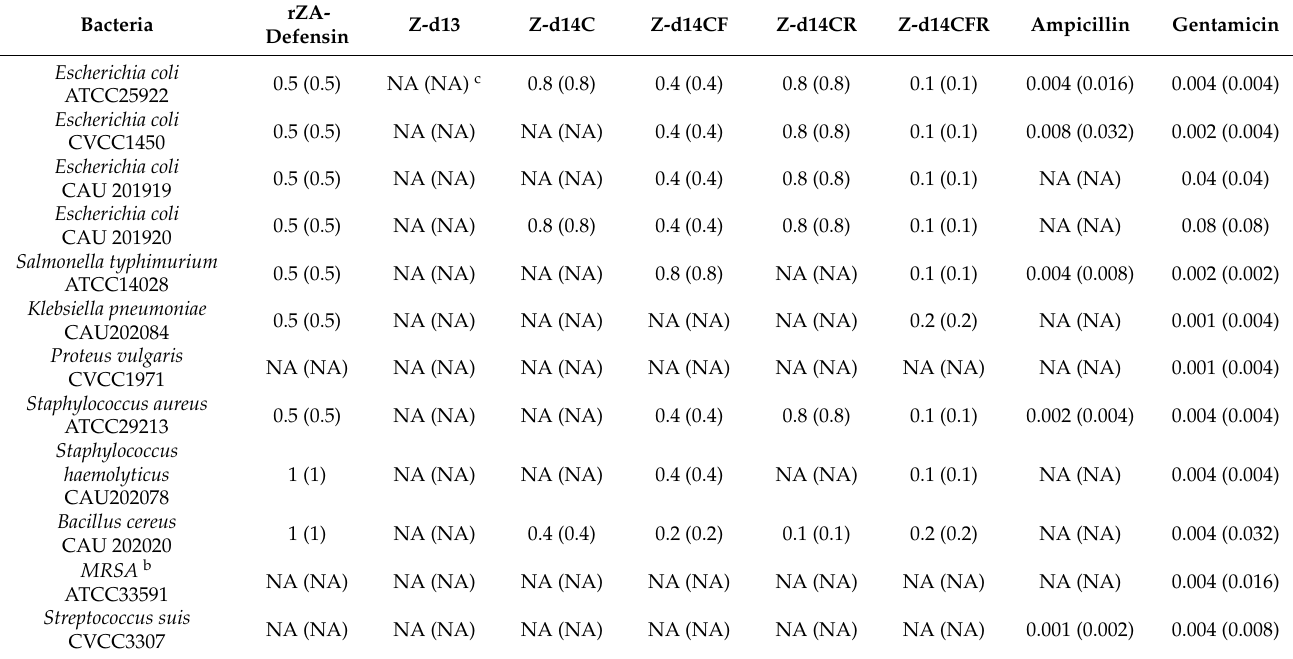
Table 2. MIC (MBC) a of Z-d14CFR against bacteria